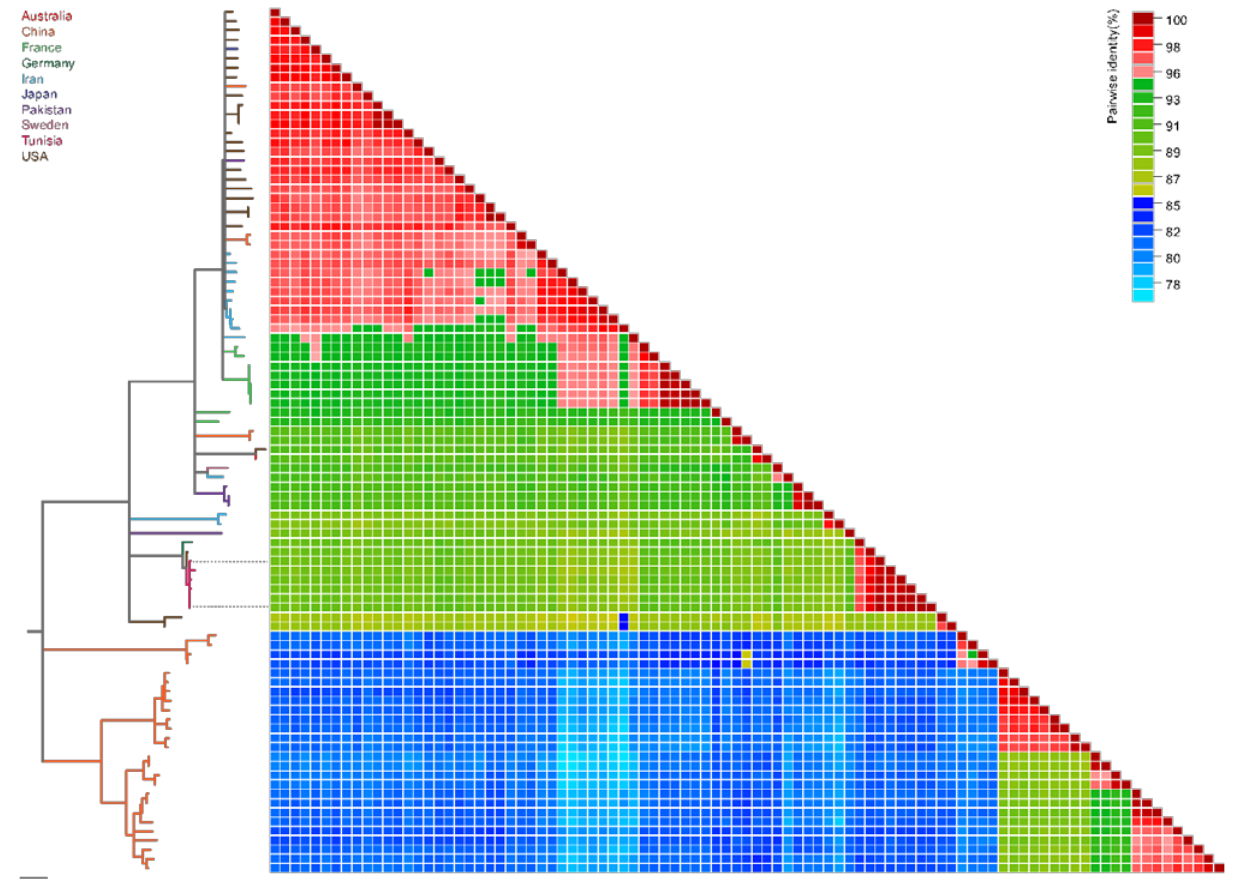
Figure 4. Maximum likelihood phylogenetic tree of BYDV-PAV sequences together with a pairwise identity